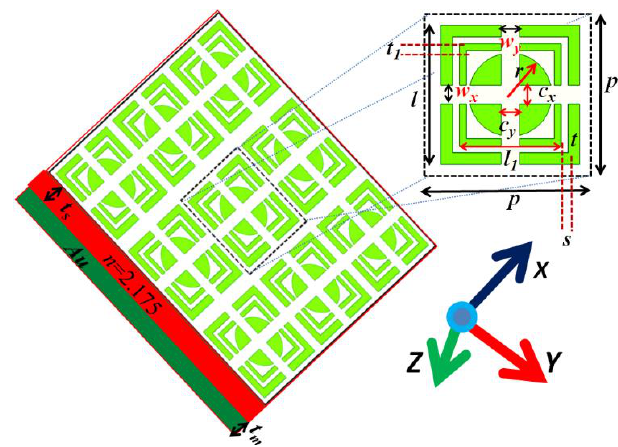
Figure 1. Schematic of the three-dimensional absorber.